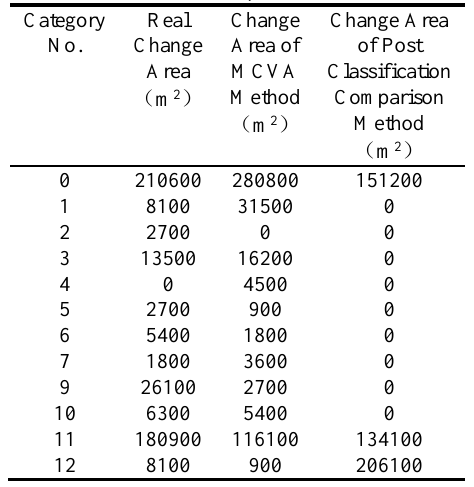
Table 8 The change detection results of MCVA method and post classification comparison method and true results from visual interpretation